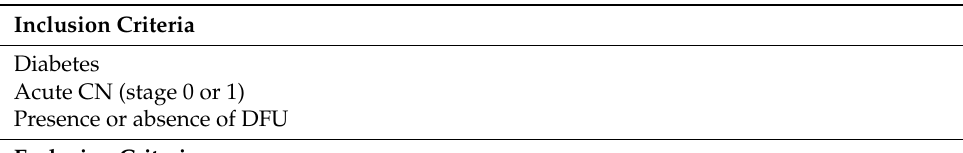
Table 1. Definition of inclusion and exclusion